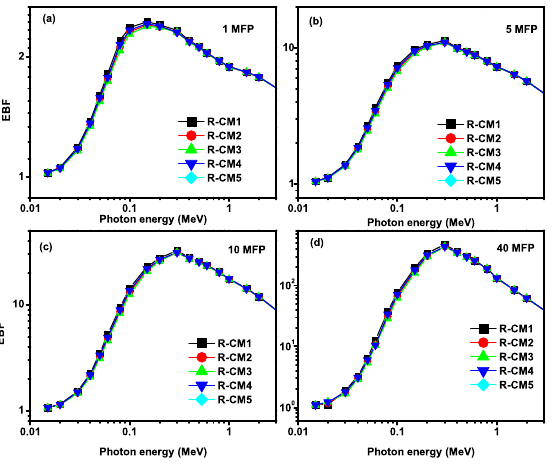
Figure 7: The EBF as a function of photon energy at 1, 5, 10 and 40 MFP